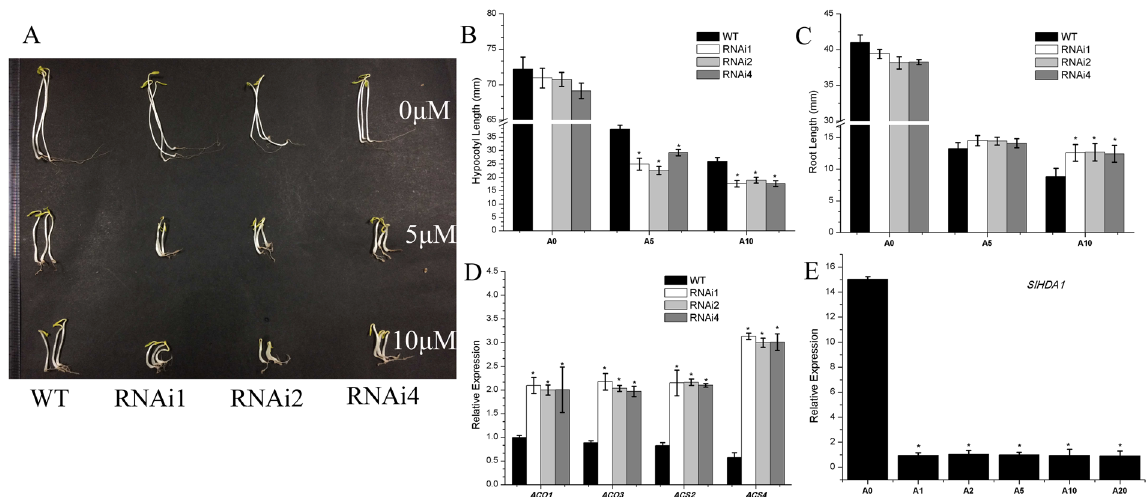
Figure 5. Ethylene triple response assay. ( A ) 20–30 seedlings of wild type (WT) and RNAi lines (RNAi 1, RNAi 2 and RNAi 4) treated with 0, 5.0 and 10.0 µ M ACC. ( B ) and ( C ) Elongation of hypocotyls ( B ) and roots ( C ) growth on different concentrations of ACC. ( D ) Expression of ACS2 , ACS4 and ACO1 , ACO3 in seedlings of RNAi lines and the wild type (WT). ( E ) Expression of SlHDA1 in seedlings of the wild type treated with 0 (A0), 1.0 (A1), 2.0 (A2), 5.0 (A5), 10.0 (A10), and 20.0 (A20) µ M ACC. Three biological replications and three technical replications for each sample were performed. Data are the means ± SD of three independent experiments. The asterisks indicate statistically significant differences between the WT and transgenic fruits (P <